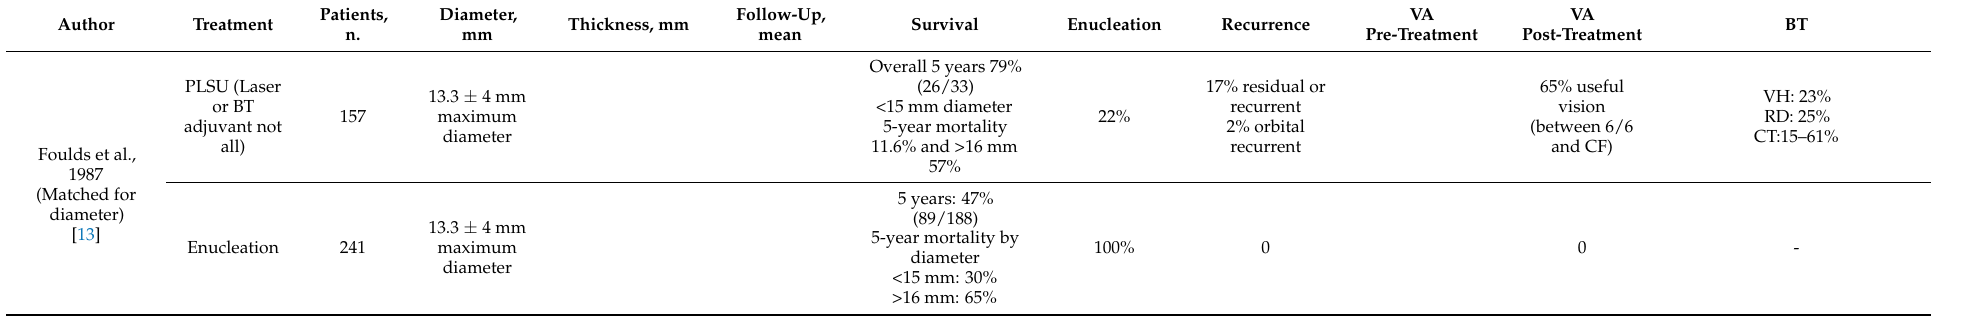
Table 3. Summary of case-control studies of partial lamellar sclerouvectomy for uveal